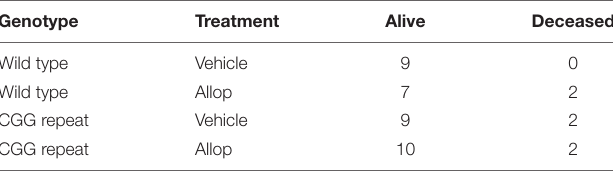
TABLE 1 | Sample sizes for each genotype and treatment